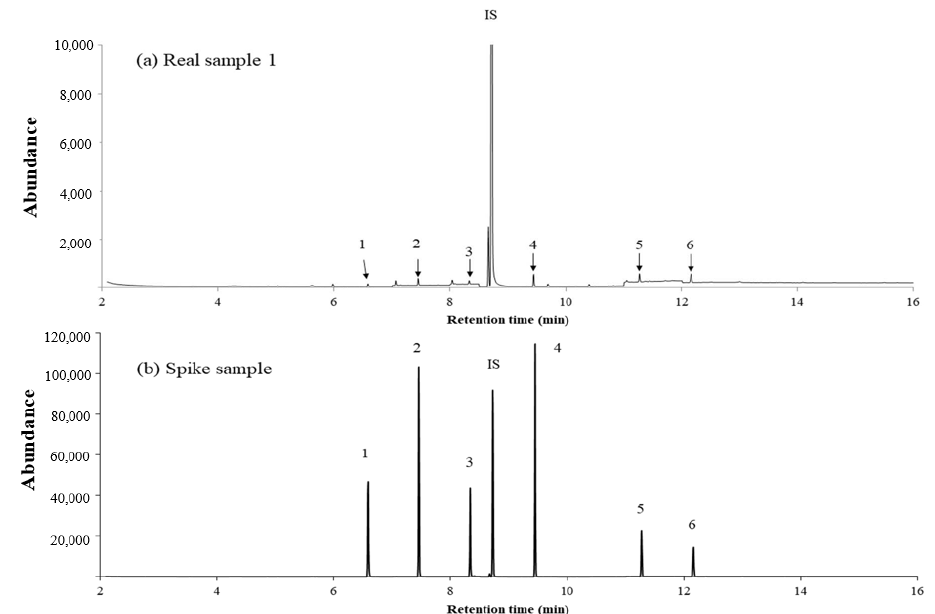
Figure 3. Chromatogram obtained from ( a ) sample 1, and ( b ) spiked sample 1 using HS−INME−MWCNT−IL/PANI. Peak 1, dimethyl phthalate; 2, diethyl phthalate; 3, diallyl phthalate; 4, dibutyl phthalate; 5, benzyl butyl phthalate; 6, di(2-ethylhexyl) phthalate; and IS, anthracene.